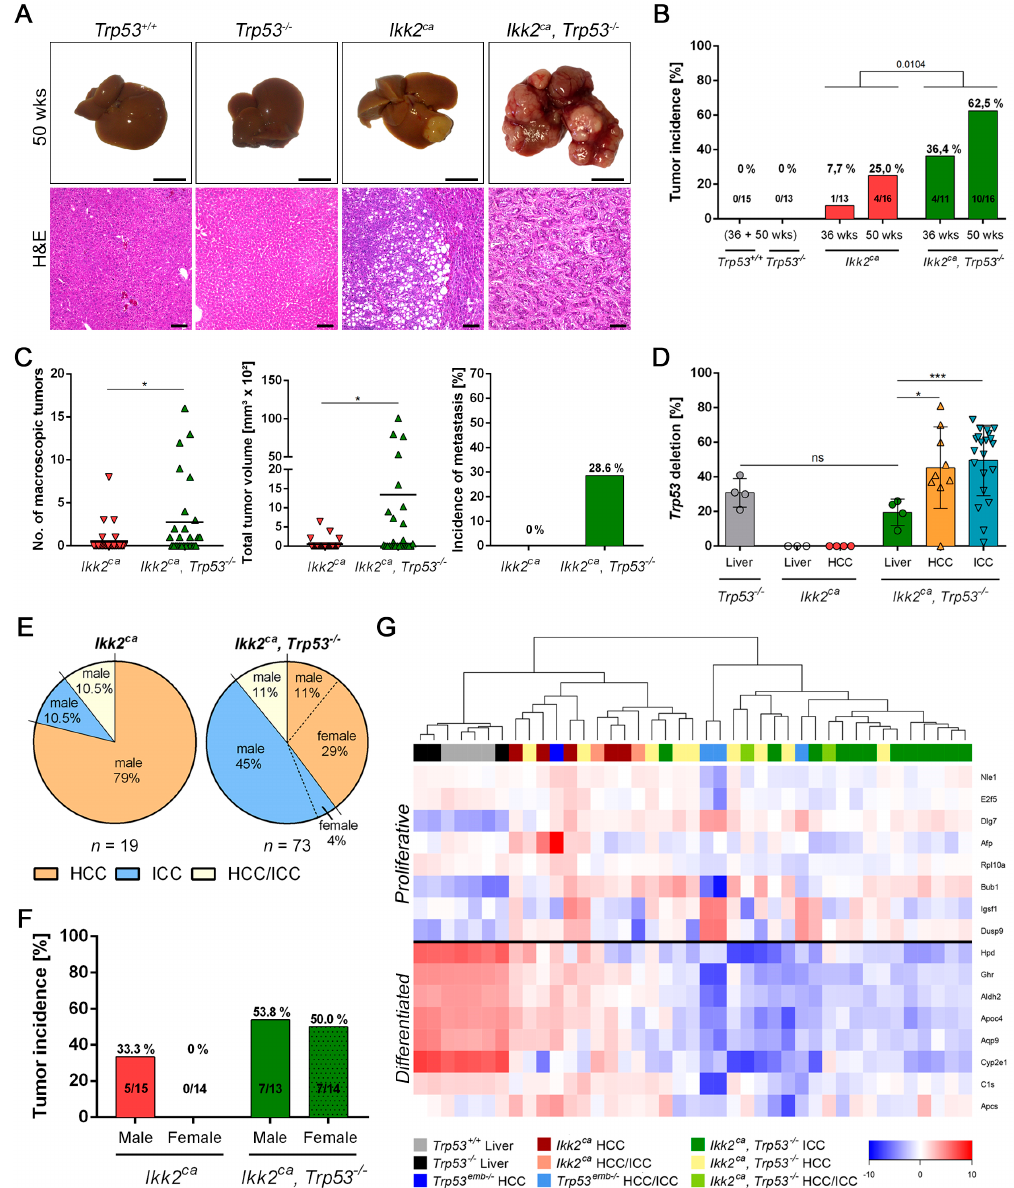
Figure 3. Trp53 deletion results in increased tumor burden and modulates tumor di ff erentiation in Ikk2 ca expressing mice. ( A ) Representative macroscopic photographs (scale bar: 1 cm) and H&E sections (scale bar: 100 µ m) of liver carcinoma in Ikk2 ca and Ikk2 ca Trp53 − / − mice. ( B ) Bar graphs represent liver tumor incidence. ( C ) Bar graph depicts tumor number, total tumor volume per mouse ( n = 29 and 27) and incidence of metastasis ( n = 5 and 14). The black line in scatter dot plots represent the mean. ( D ) Combined scatter dot plot bar graph represents the Trp53 deletion rate in liver and liver carcinoma of the indicated genotype at the age of 50 weeks ( n = 4–21). Bar graph of Trp53 deletion represent the mean ± SD; * p < 0.05, ** p < 0.01, **** p < 0.0001. ( E ) Pie charts depict tumor di ff erentiation of the indicated gender of Ikk2 ca ( n = 19) and Ikk2 ca Trp53 − / − ( n = 73) mice. ( F ) Gender-specific tumor incidence of Ikk2 ca and Ikk2 ca Trp53 − / − mice. ( G ) Relative mRNA expression of a 16-gene signature of the indicated tissue and